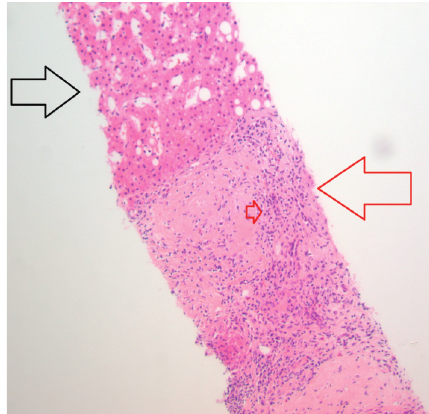
Figure 3: Low-power view showing benign liver tissue (black arrow) and granulomas (red arrow). The small red arrow shows palisading histiocytes surrounding a central fibrous area of the